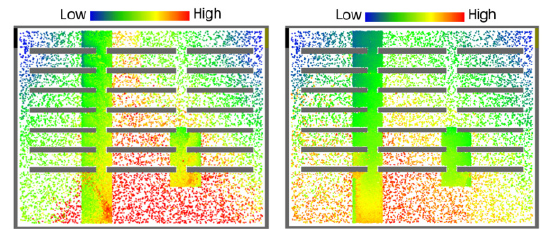
Fig. 25 Evacuation time distribution for the agents. Left: dynamic method. Right: our method.